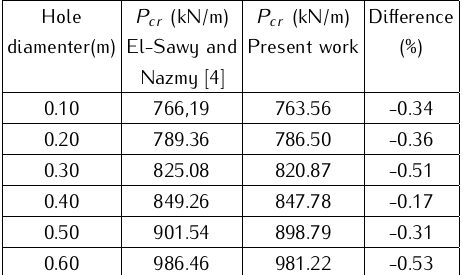
Table 2. Comparison of critical buckling load for plate with centered circular